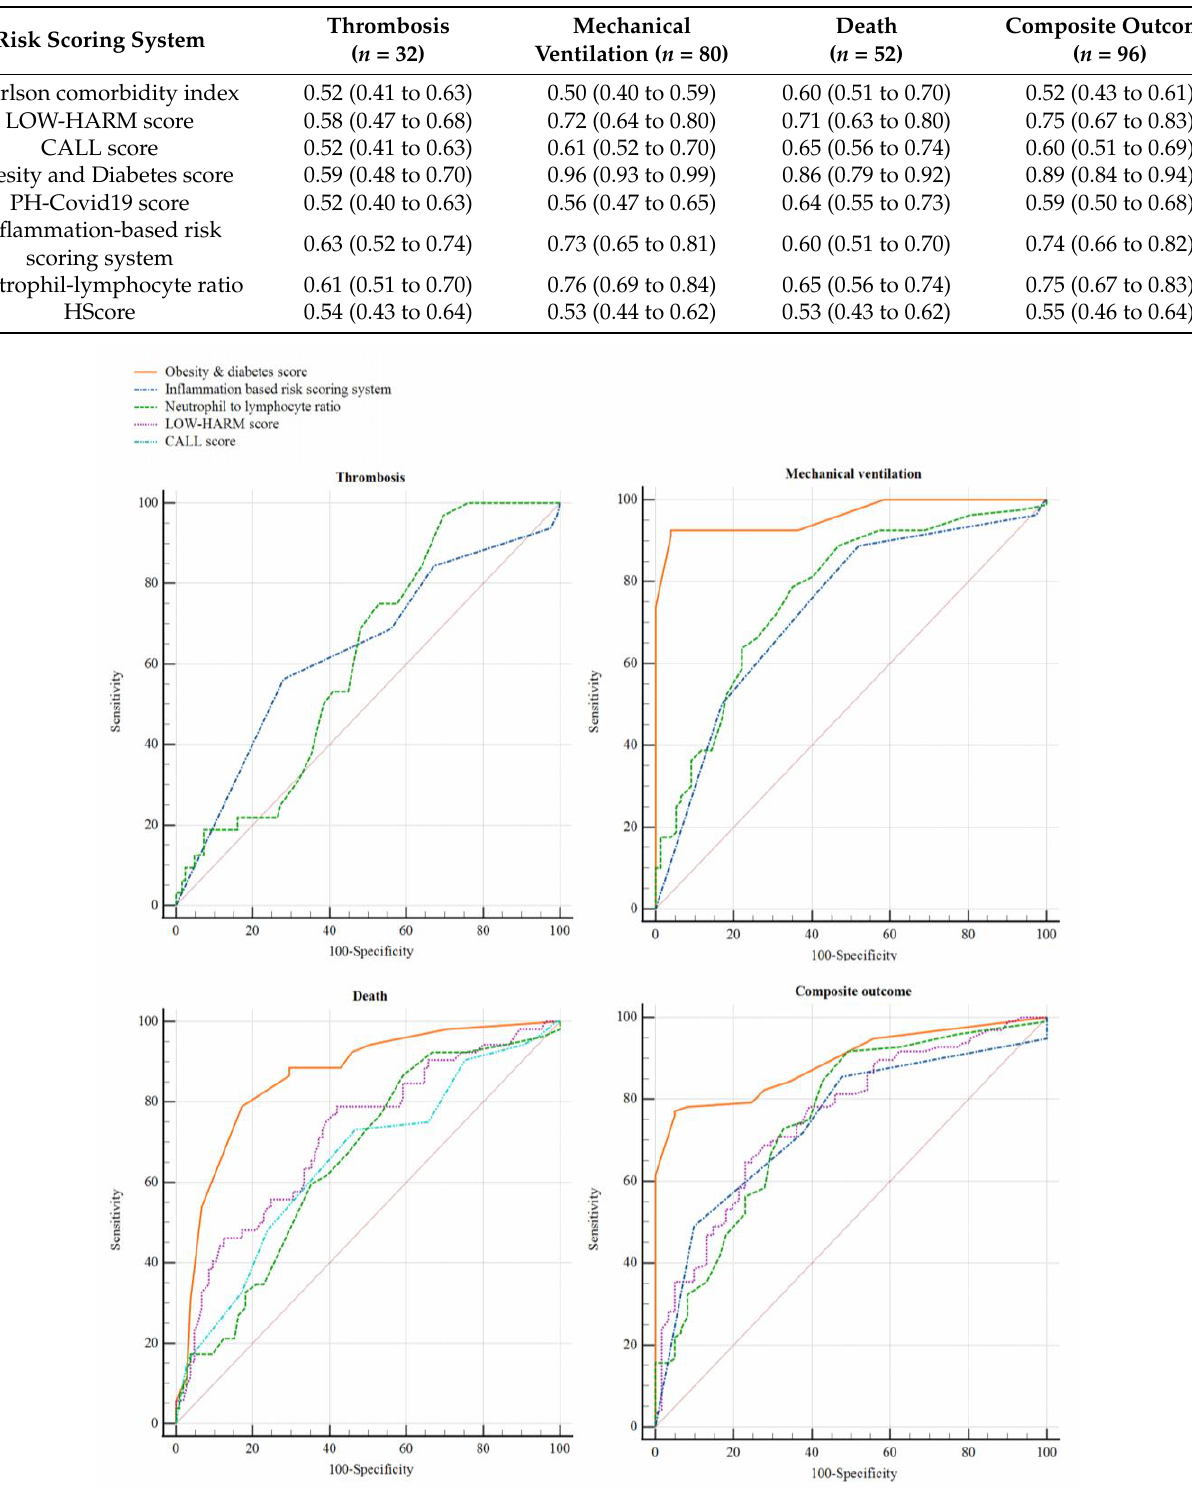
Figure 1. A comparative ROC analysis of the risk scoring systems that significantly discriminated the occurrence of each major adverse outcome. The inflammation-based risk scoring system was not better than the neutrophil-lymphocyte ratio ( p = 0.737) in predicting thrombosis. In contrast, the Obesity and Diabetes score was better than any of the other risk scoring systems in predicting the need for mechanical ventilation ( p < 0.0001 for all comparisons), death ( p < 0.001 for all comparisons), and the composite outcome ( p < 0.01 for all comparisons).